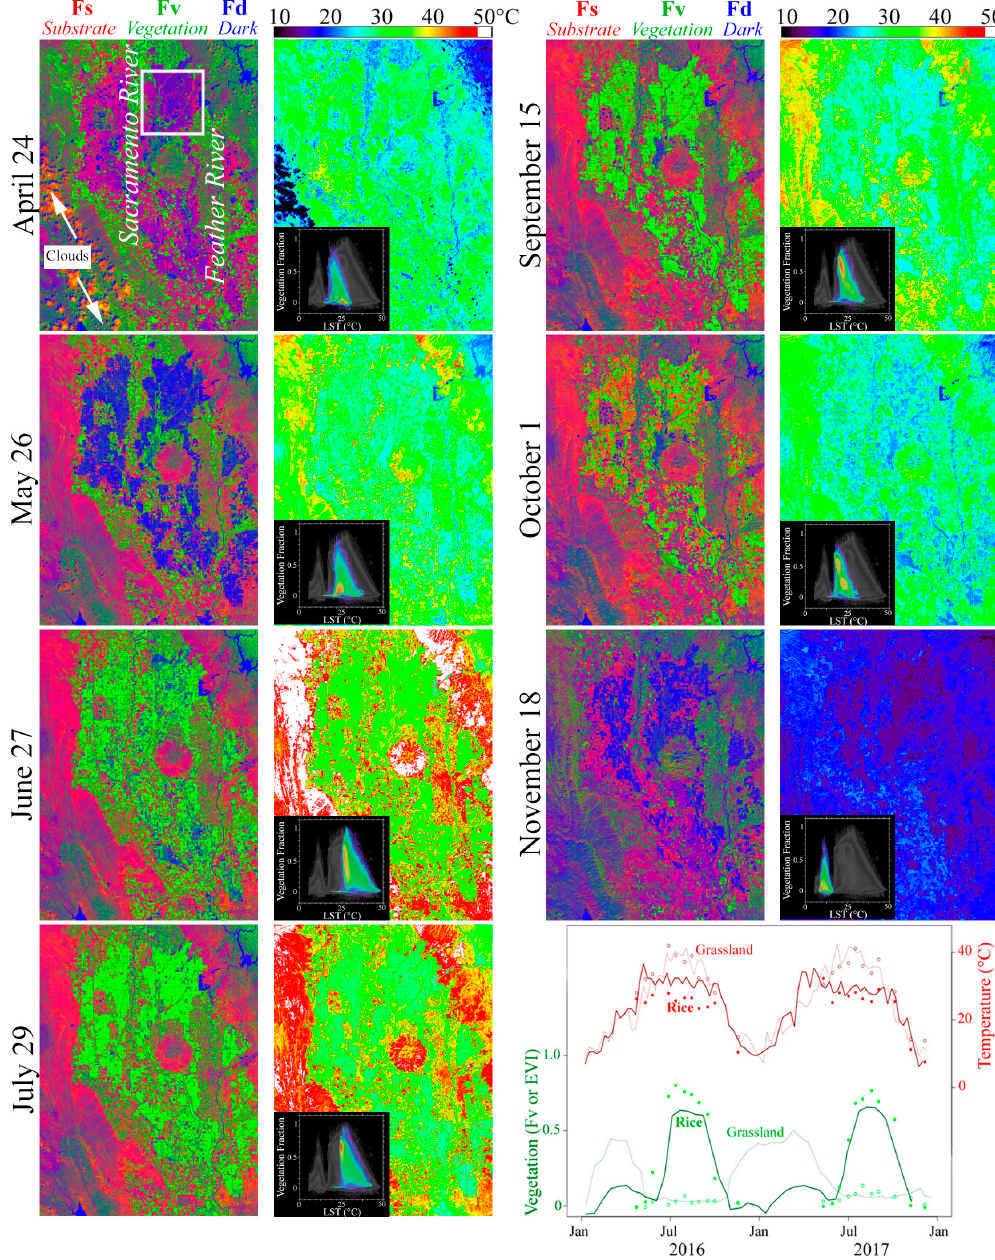
Figure 4. Multisensor evolution of land cover and temperature. Image time series shows Landsat EM fraction abundance (F s , F v , and F d ; 1st and 3rd columns) and LST (2nd and 4th columns). Fraction images show bare fields (dark red, mixture of F s and F d ) prepared in Apr, flooded (dark blue, high F d ) in May, greening up from Jun to Sep (from dark green to bright green, tradeoff between F d and F v ), senescing and being harvested (orange and yellow, tradeoff between F v and F s ) in Oct and Nov. Thermal images are dominated by the seasonal cycle, with amplitude modulated by ET. Dry grasslands and fallow fields can reach summer LST of 20 °C greater than flooded rice fields. In winter, differences in LST between land covers are reduced. Inset plots show LST (X) vs F v (Y) for each scene (in color) relative to all 22 scenes from 2016+2017 (in grayscale). White box on the Apr image indicates the area used for the characterization shown in Figures 5a and 5b. Inset time series shows comparison between Landsat F v + LST (dots) and MODIS EVI + Land Surface Temperature composites (lines).